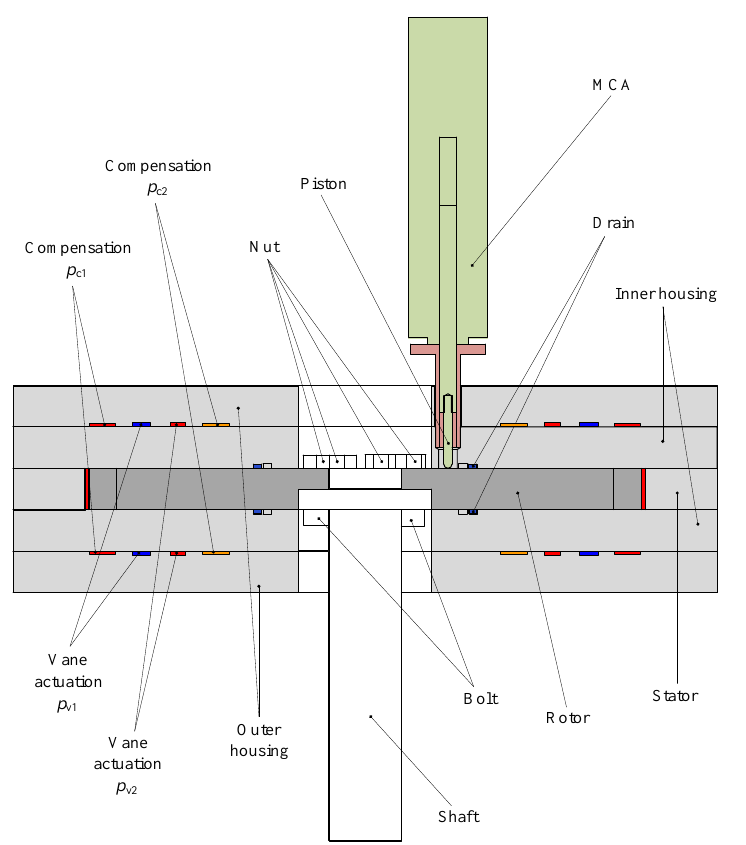
Figure 4: Section cut of the prototype motor. The moving coil actuator (MCA) is mounted on the inner housing and the piston is forced against the end face of the rotor during